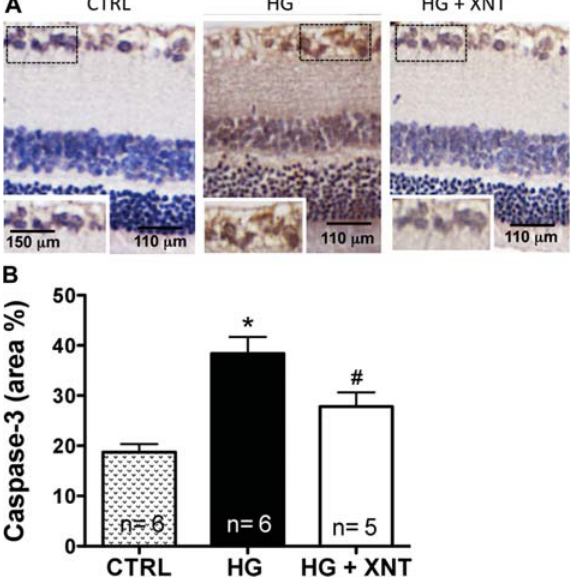
Figure 4. Effects of XNT on vascular endothelial growth factor (VEGF) expression in retinas. A , Representative photomicro- graphs of retinas of control rats (CTRL), hyperglycemic untreated rats (HG), and hyperglycemic treated rats (HG + XNT). The white arrows show VEGF-positive expression. B , Quanti fi cation of VEGF expression in retinas. No signi fi cant differences were observed among the groups (one-way